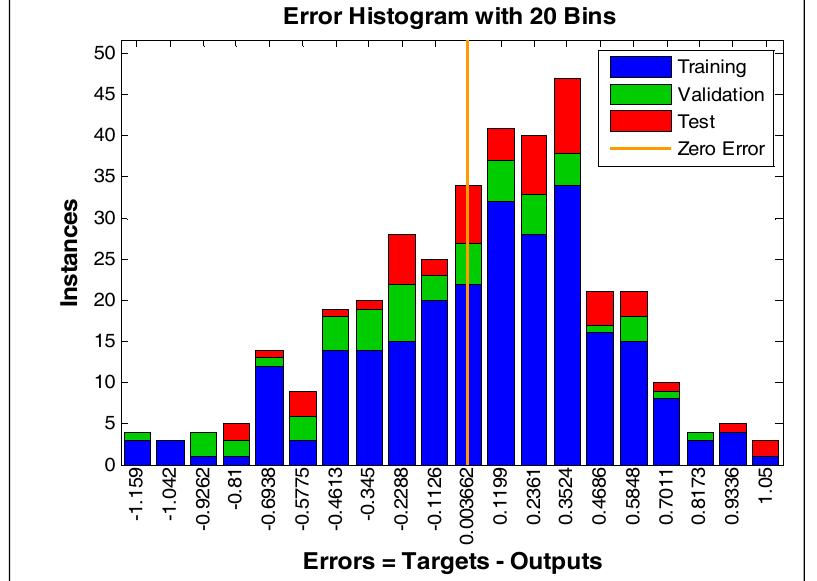
Figure 9. Error histogram of input model number 1.